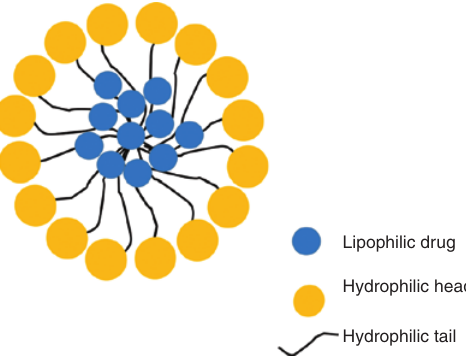
Figure 6: Schematic illustration of